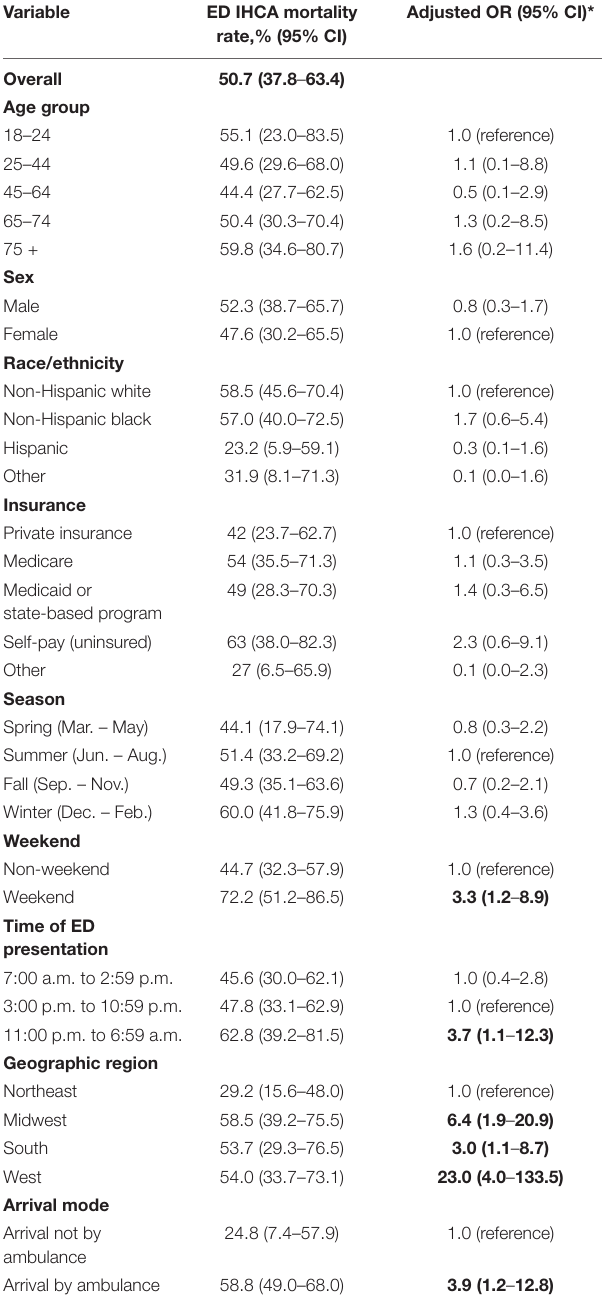
TABLE 3 | Emergency department in-hospital cardiac arrest mortality rates, overall, stratified, and multivariable analysis,